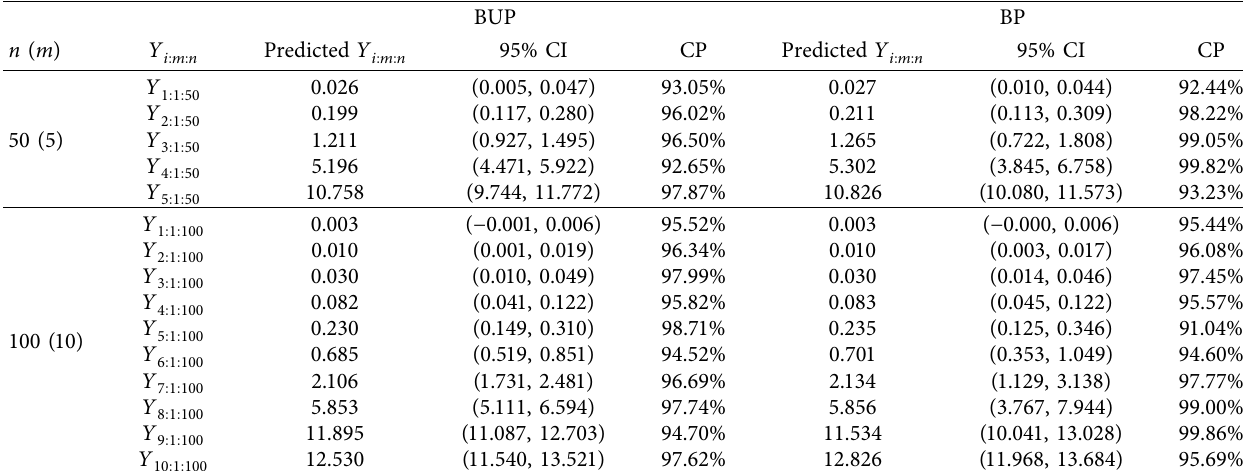
, 1 ≤ i ≤ m , for scheme 2, with α � 0 . 5 , β � 0 . 5. i : m : n BUP BP